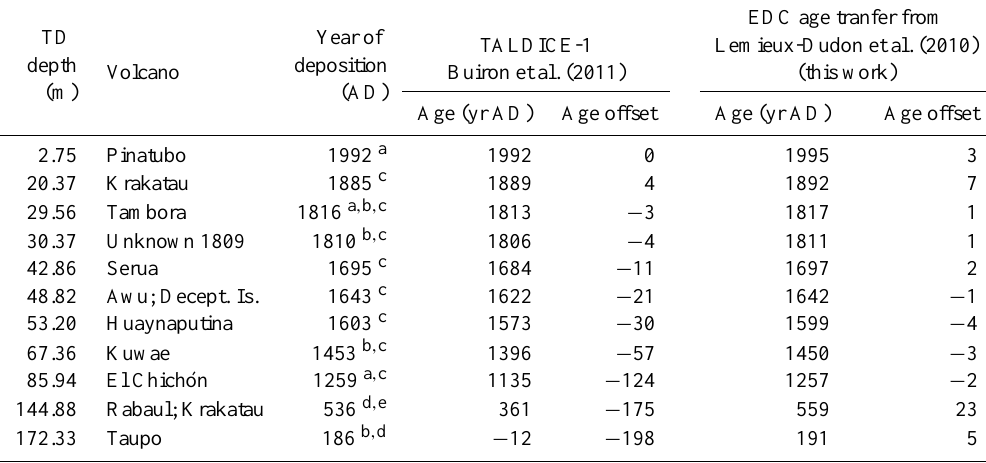
Table 1. List of the historically known volcanic events occurred in the last two millennia and recorded in the TD ice core. The corresponding depths and years of the deposition are listed. For both age scales (TALDICE-1 and the new one proposed in this work) the calculated deposition year and age offset are reported in the table.